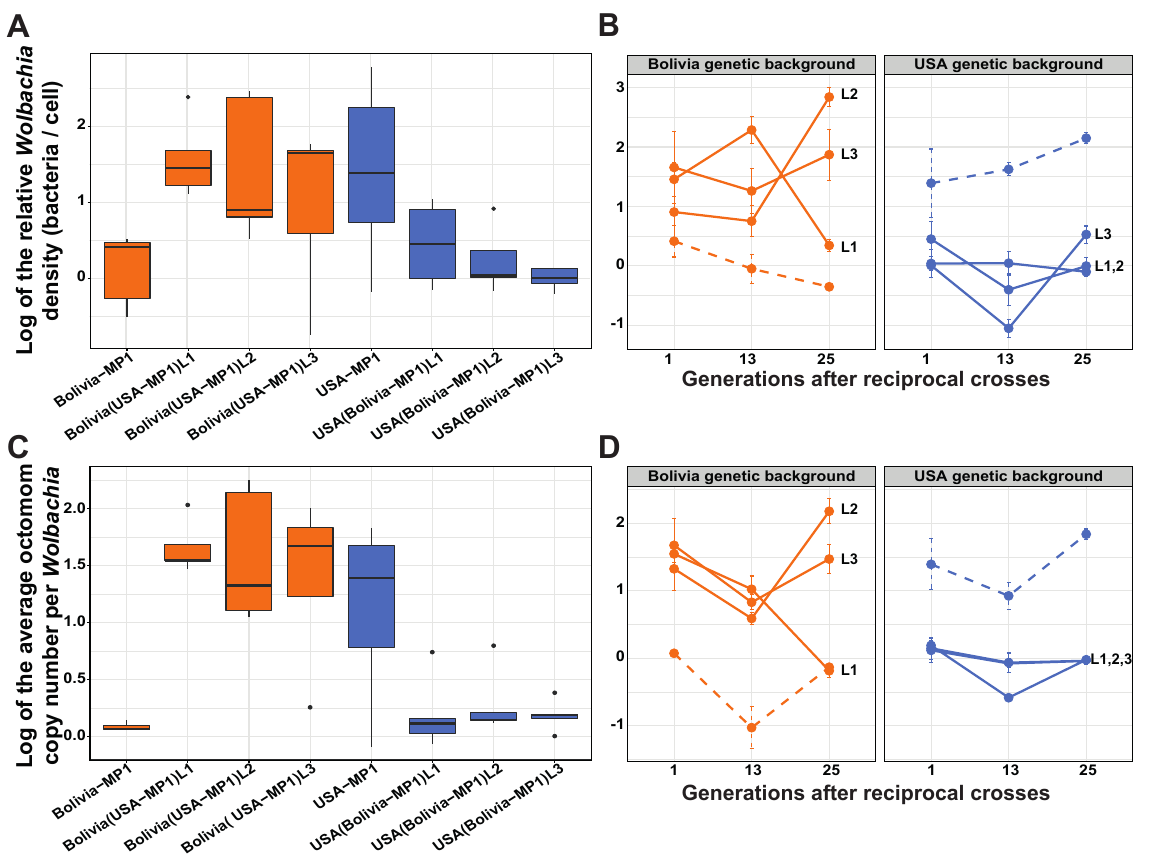
Figure 5: Evolution of infection patterns after reciprocal crosses. 5A: Relative density (log) one generation post introgression (box plot with ‘minimum’, 1 st quartile, median, 3 rd quartile, and ‘maximum’ ± outliers (dots)). 5B: Evolution of the relative density (log) over generations (median ± SE). 5C: Average Octomom copy number per Wolbachia (log) one generation post introgression. 5D: Evolution of the average Octomom copy number per Wolbachia (log) over generations (median ± SE). N = 5 flies / line / timepoint. Each color represents a host genetic background and the information in brackets represents the bacterial genetic background. Plain lines represent the replicate lineages from the reciprocal crosses, L1, L2 and L3 indicating the replicates. Dashed lines represent the lineages from the initial introgression procedure (MP1), which were used as references in the statistical